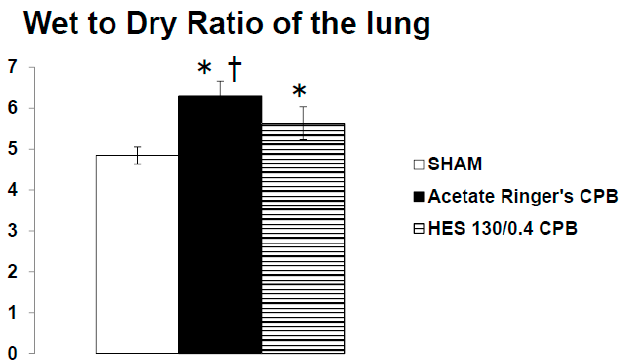
Figure 8. The wet-to-dry ratio of the lung at the end of experiment [35]. * p < 0.05 versus the SHAM group, † p < 0.05 versus the HES 130/0.4 CPB group.